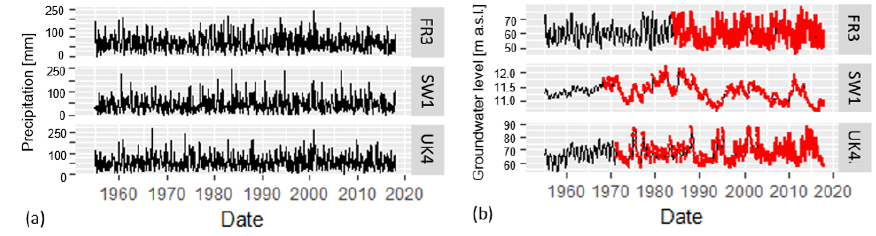
Figure 3. (a) Time series of precipitation (mm/month), and (b) observed (red) and simulated (black) time series of groundwater levels for selected sites (FR3, SW1, and UK4) in metres above sea level (ma.s.l.). Daily precipitation data was extracted from the E-OBS dataset and used to calculate the monthly accumulated rainfall for each site.